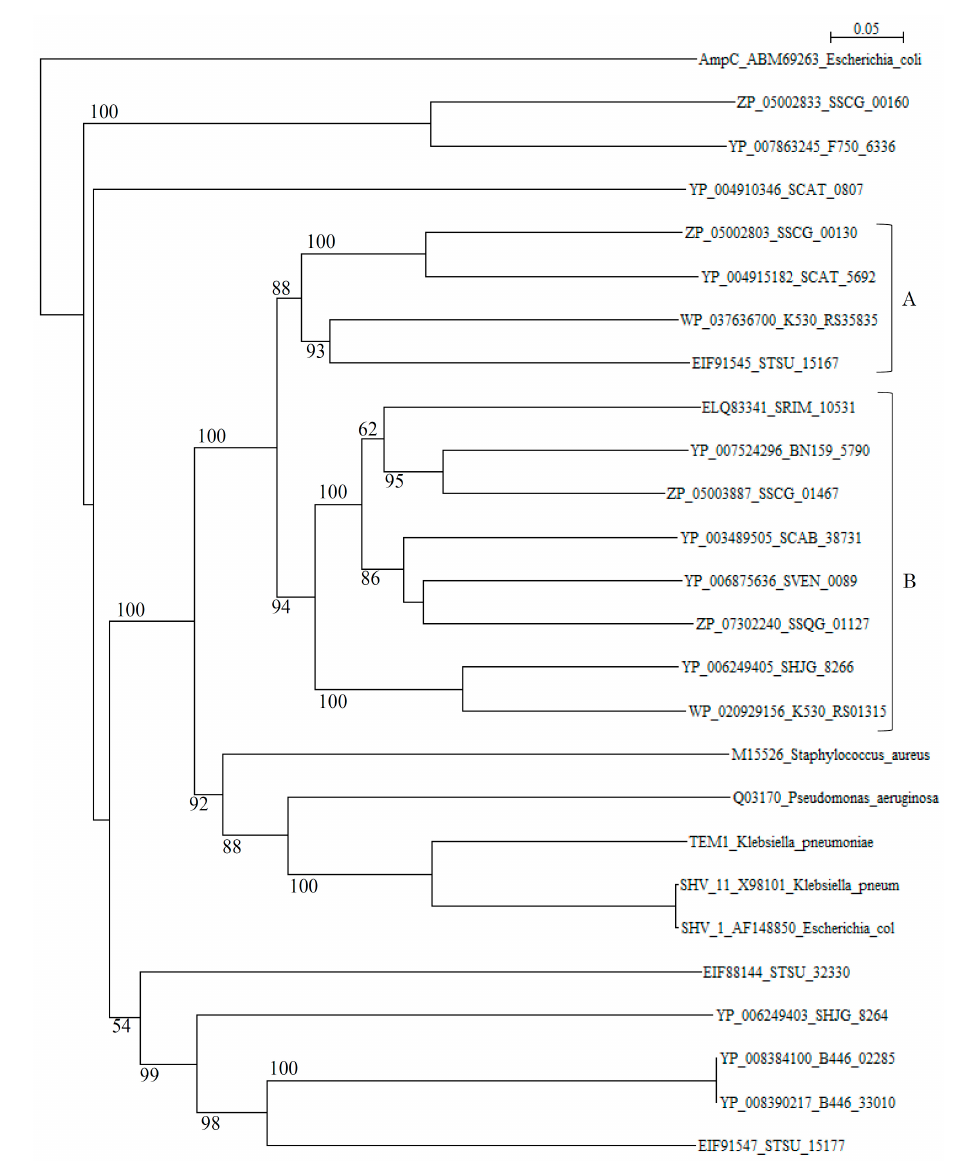
Figure 1. Phylogenetic tree of putative 20 class A β -lactamases on the basis of amino acid sequences with those of Staphylococcus aureus (M15526), Pseudomonas aeruginosa (Q03170), Klebsiella pneumoniae (TEM-1, YP_005351445), Klebsiella pneumoniae (SHV-11, X98101), and Escherichia coli (SHV-1, AF148850) as reference sequences. The tree was constructed by using ClustalX 2 [88] and E. coli AmpC (ABM69263) as outgroup. Clusters A and B show blue-dextran/NADP + -non-binding and binding β -lactamases from Streptomyces , respectively and, cluster C shows those from pathogenic bacteria used as reference sequences. The bootstrap probabilities are shown at branching